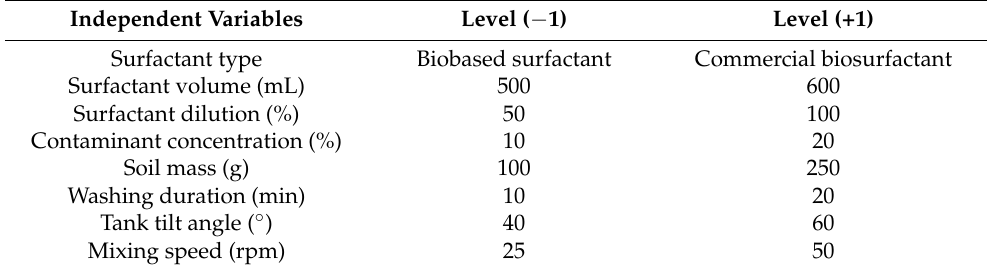
Table 2. Variables and levels considered in the 2 8-4 fractional factorial design. Decoded